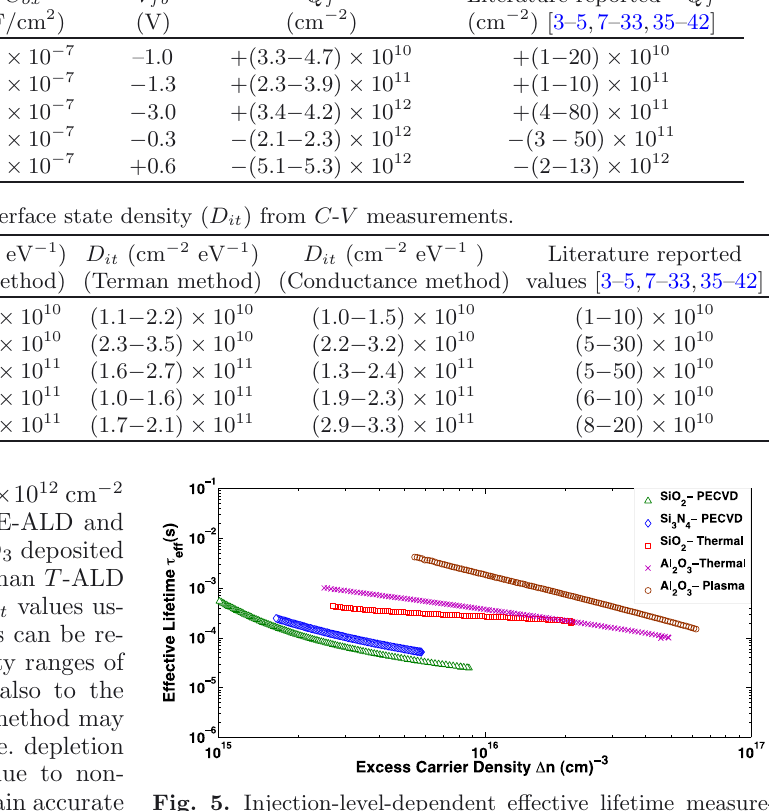
Fig. 5. Injection-level-dependent effective lifetime measure- ments on different dielectrics